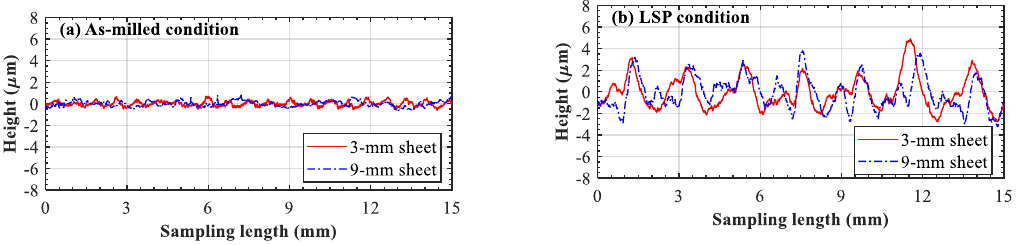
Figure 3. Surface roughness of the two LPF sheets: ( a ) as-milled condition and ( b ) laser-peened condition.